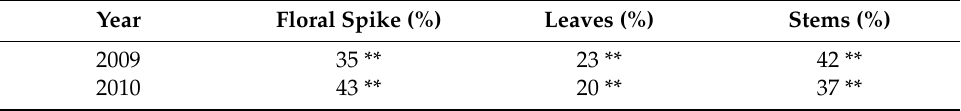
Table 3. Percentage distribution of biomass components (d.m.).